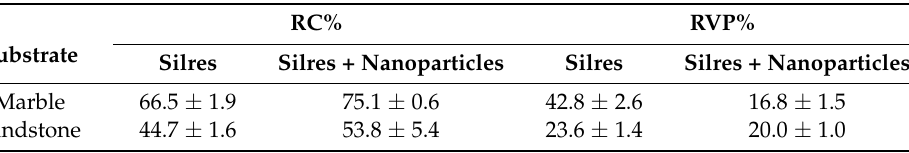
Table 2. Results for the relative reduction of water absorption by capillarity (RC%) and vapour permeability (RVP%) for marble and sandstone specimens covered by Silres and Silres + nanoparticles coatings. Calculations were carried out using Equations (2) and (3).